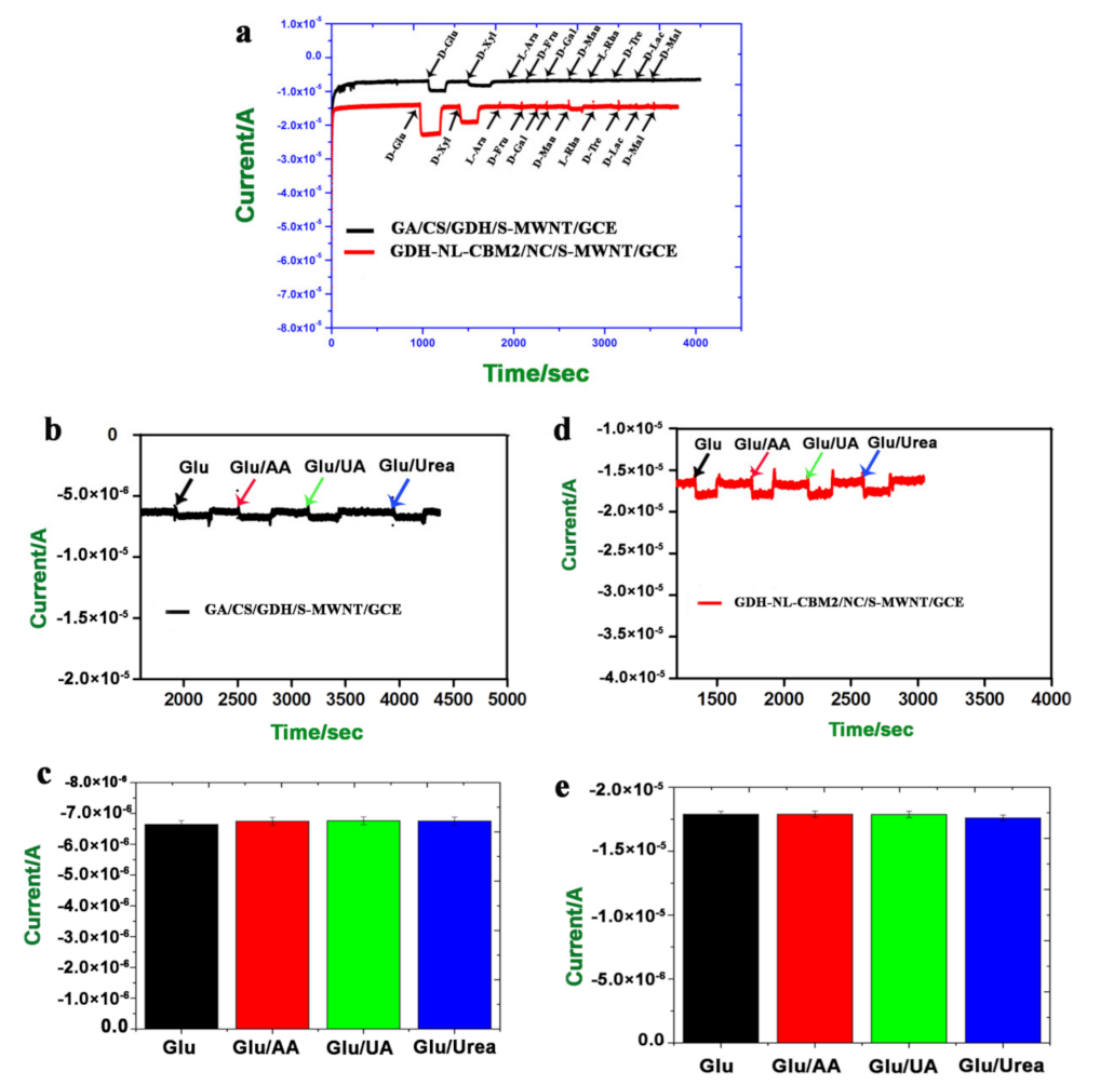
Figure 7. Specificity and anti-interference analysis of the GA/CS/GDH/S-MWCN/GCE and GDH-NL-CBM2/NC/S- MWNT/GCE electrodes by the time–current method. ( a ) Substrate specificity detected by adding various sugars (100 mM, 25 µ L), including D -xylose, L -arabinose, D -fructose, D -galactose, D -mannose, D -rhamnose, and D -trehalose, D -lactose, and D -maltose; ( b , c ) Anti-interference ability of the GA/CS/GDH/S-MWCN/GCE studied by adding ascorbic acid (AA, 50 µ M), uric acid (UA, 0.2 mM), and urea (2 mM) with their respective final concentrations in the human serum with 5 mM glucose; ( d , e ) Anti-interference ability of the GDH-NL-CBM2/NC/S-MWNT/GCE studied by adding ascorbic acid (AA, 50 µ M), uric acid (UA, 0.2 mM), and urea (2 mM) with their respective final concentrations in the human serum with 5 mM